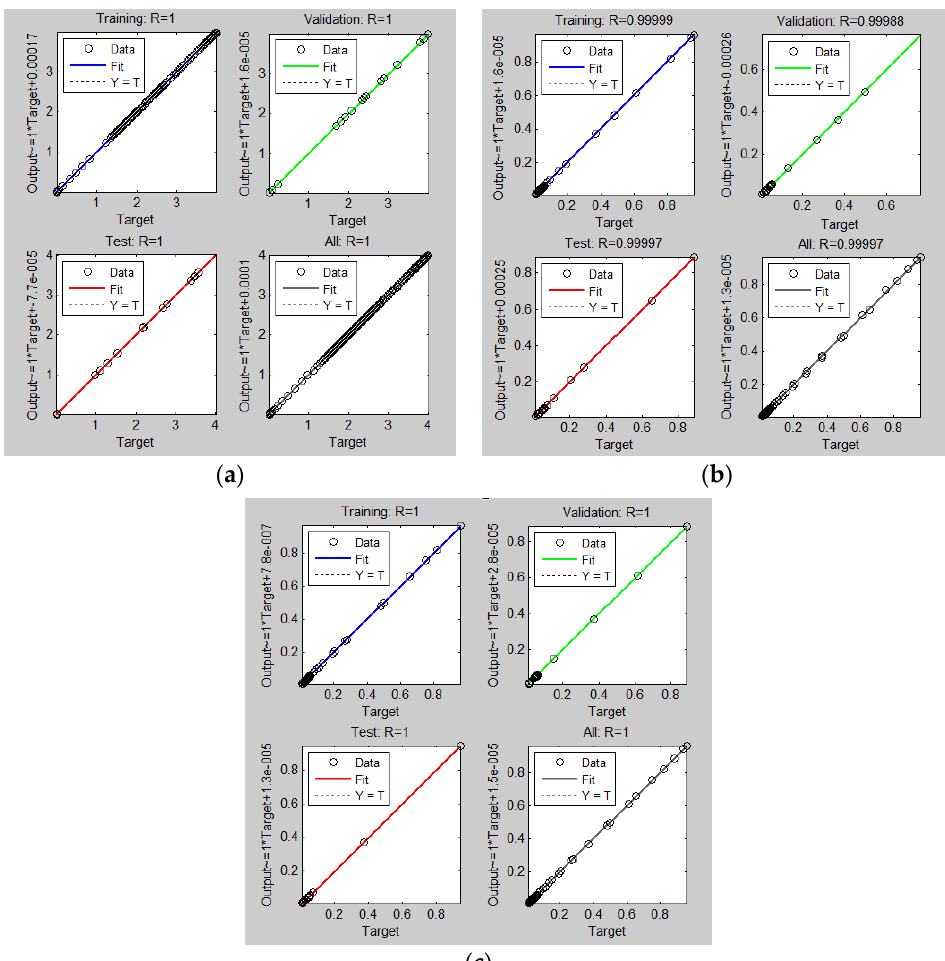
Figure 4. ( a ) Fitness plots for training, validation, testing and all data sets of the ANN to predict E′ ( T ); ( b ) Fitness plots for training, validation, testing and all data sets of the ANN to predict E′′ ( T ); and, ( c ) Fitness plots for training, validation, testing and all data sets of the ANN to predict tan δ( T ).